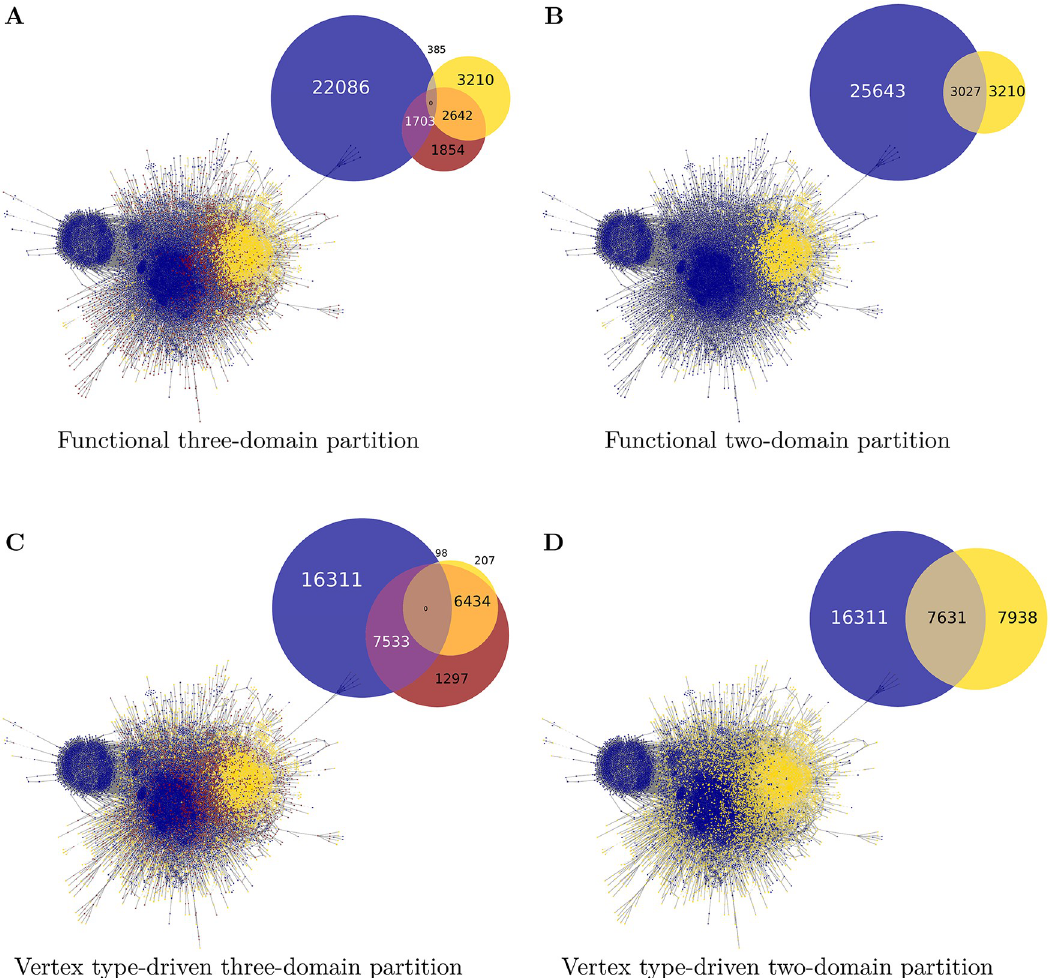
Fig 3. Graph snapshots of the four partitions. The functional three-domain partition into metabolic and regulatory domains and protein interface (MD—PI—RD) ( A ), the functional two-domain partition into metabolic and regulatory domains (MD—RD) ( B ), vertex-driven three-domain partition into compounds/reactions, proteins and genes ( C ), vertex-driven two-domain partition into compounds/reactions, and proteins/genes ( D ). Vertices are colored according to their domain-affiliation: yellow–(pseudo) regulatory and gene-focused domain, respectively, and blue—(pseudo) metabolic and compound-focused domain, respectively. The interface domain in the three-domain partitions are drawn in red. The diagrams in the top right corners of each panel show the edge composition of the system in terms of intra-domain and inter-domain